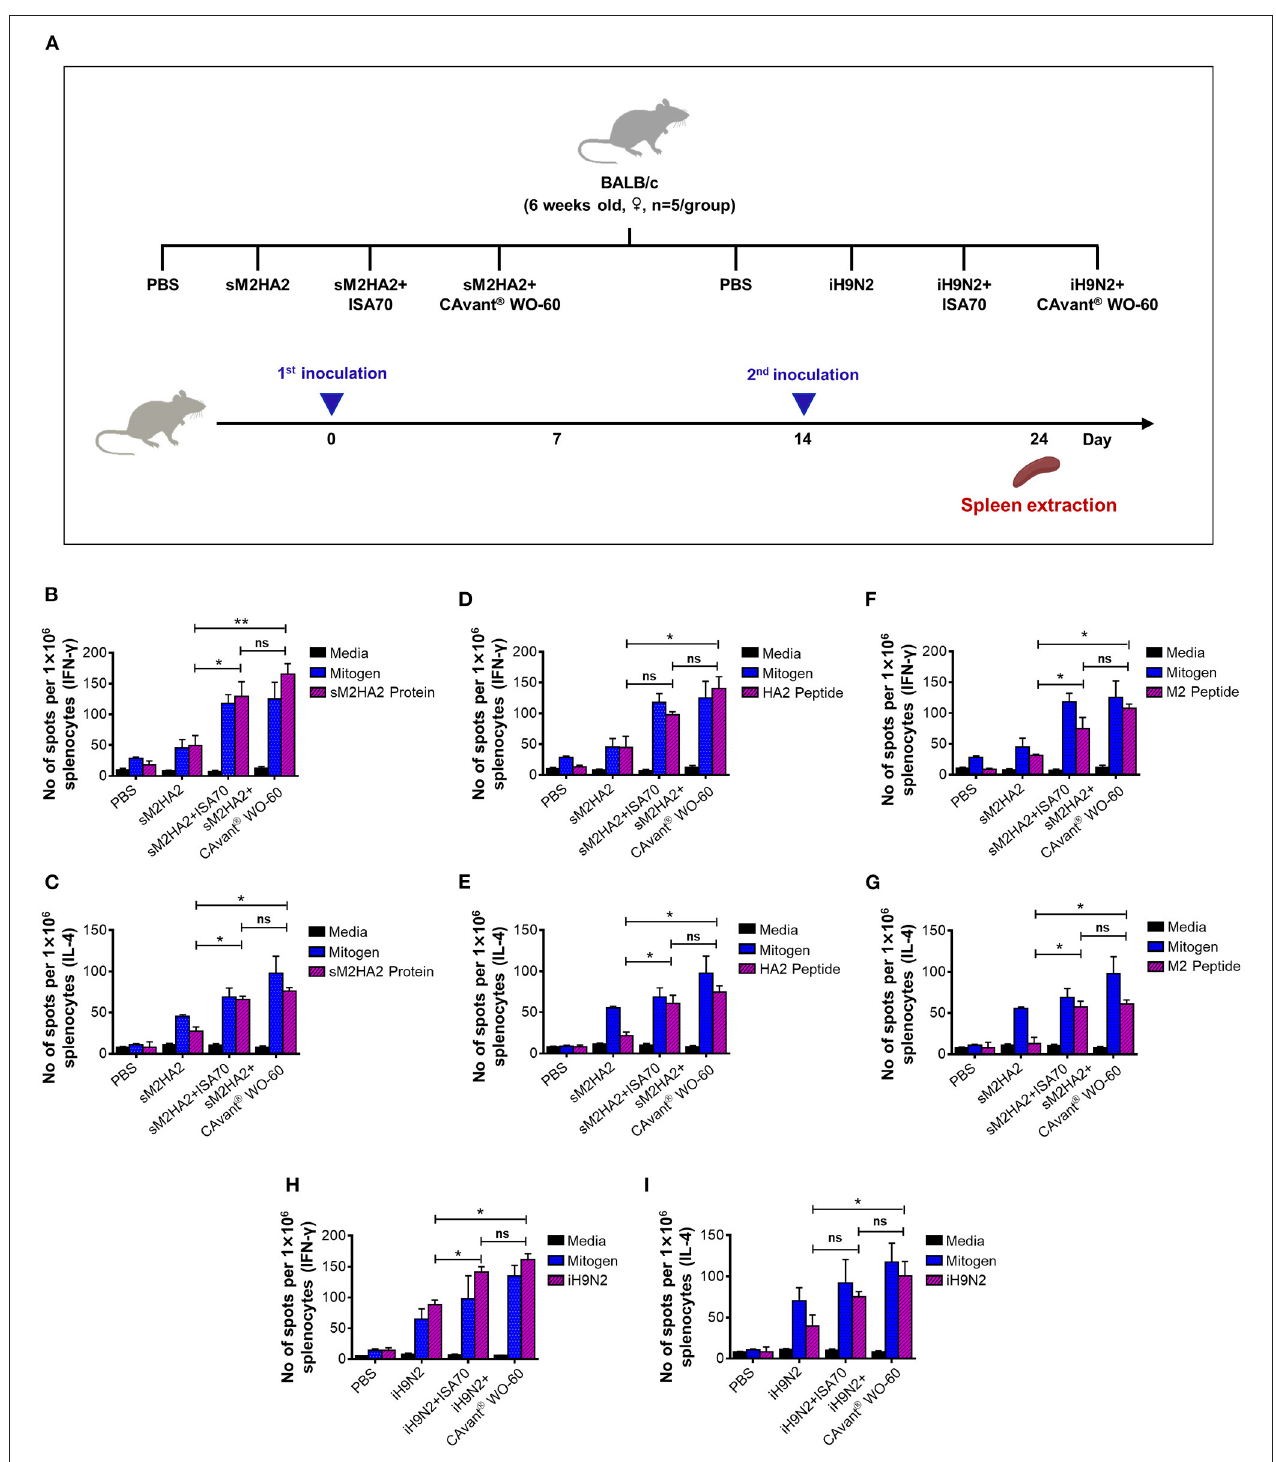
FIGURE 2 | Evaluation of the cell-mediated immune responses in mice. (A) Schematic depiction of mice experiment strategy. Splenocytes were harvested 10 days after the last immunization. Cells were re-stimulated in vitro with the (B,C) sM2HA2 protein, (D,E) HA2 peptide, (F,G) M2 peptide, and (H,I) iH9N2 and IFN- γ and IL-4 spot forming cell were determined by ELISPOT assay. The bar shows the mean ± SD of n = 5 samples. Data from one representative experiment of two independent experiments are shown. Comparison of groups was analyzed by ANOVA and Tukey’s multiple comparisons test. * p < 0.05, ** p < 0.01 between CAvant ® WO-60 adjuvanted, ISA 70 VG adjuvanted, and antigen-only